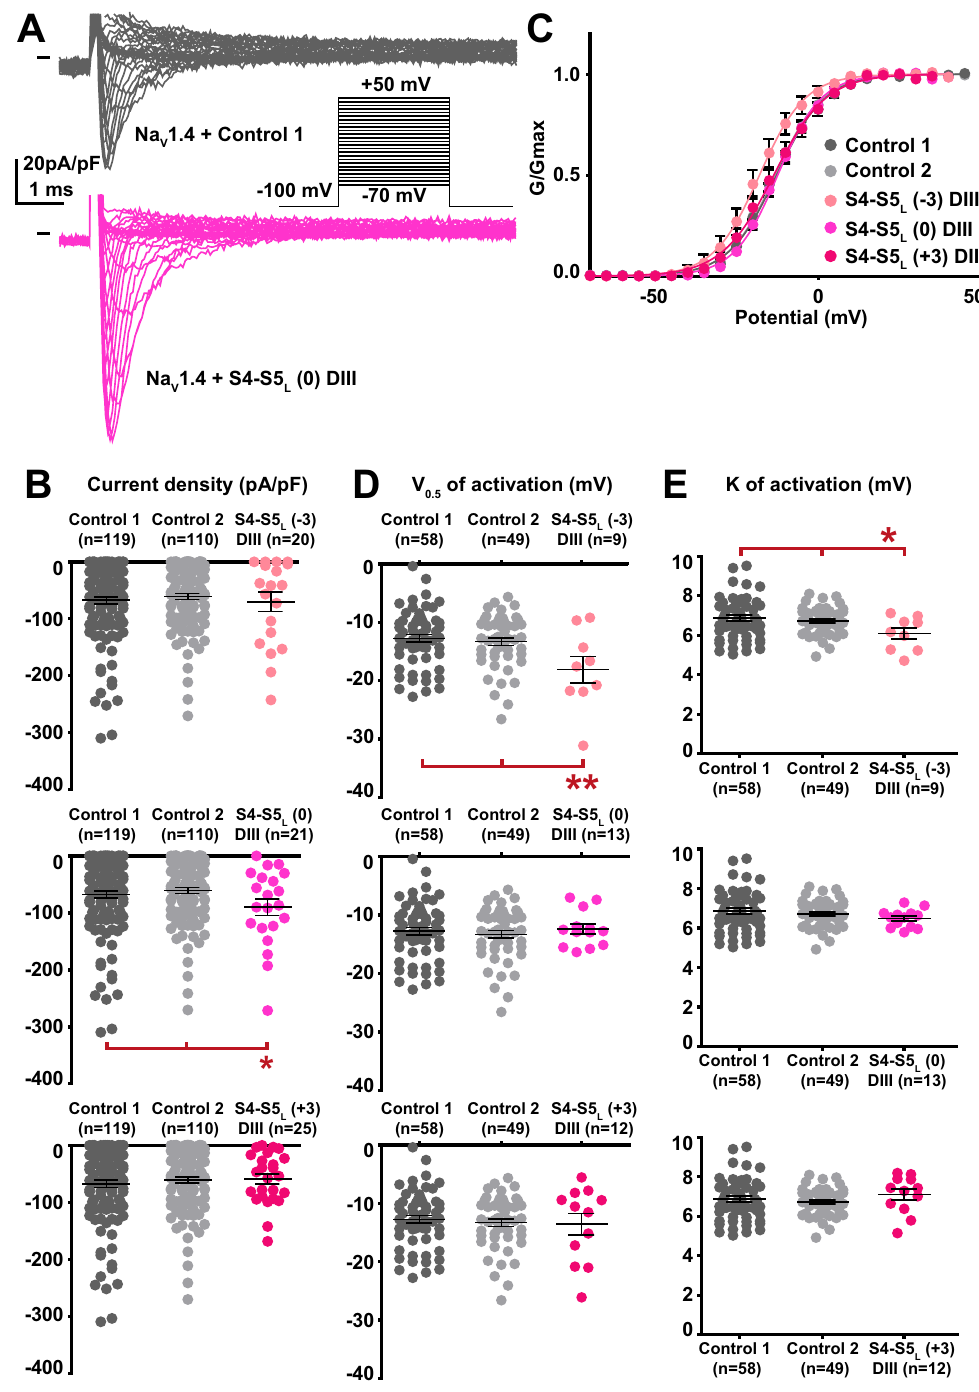
Figure 7. Effect of Na V 1.4 S4-S5 L mimicking peptides of domain III on Na V 1.4 current density and activation curve. ( A ) representative, superimposed current recordings in COS-7 cells co-transfected with Na V 1.4, Na V ß1, and control 1 (top trace) or domain III S4-S5 L (0) peptide (bottom trace). Inset: activation voltage protocol used (holding potential: − 100 mV; 30-ms pulse; one sweep every 2 s). ( B) Dot plot and mean ± sem of peak Na V 1.4 current densities recorded in COS-7 cells co-transfected with Na V 1.4, Na V ß1, and the indicated peptide, at 0 mV. C: Relative peak conductance versus membrane potential curves for Na V 1.4 channels in the same cell groups as in ( B) . Lines are Boltzmann fits to the data. ( D , E) Dot plot and mean ± sem of Na V 1.4 half-activation potential (V 0.5 ; D ) and activation slope (K; E ) in the same cells group as in ( B) . * p value vs . both controls < 0.05. ** p value vs . both controls <